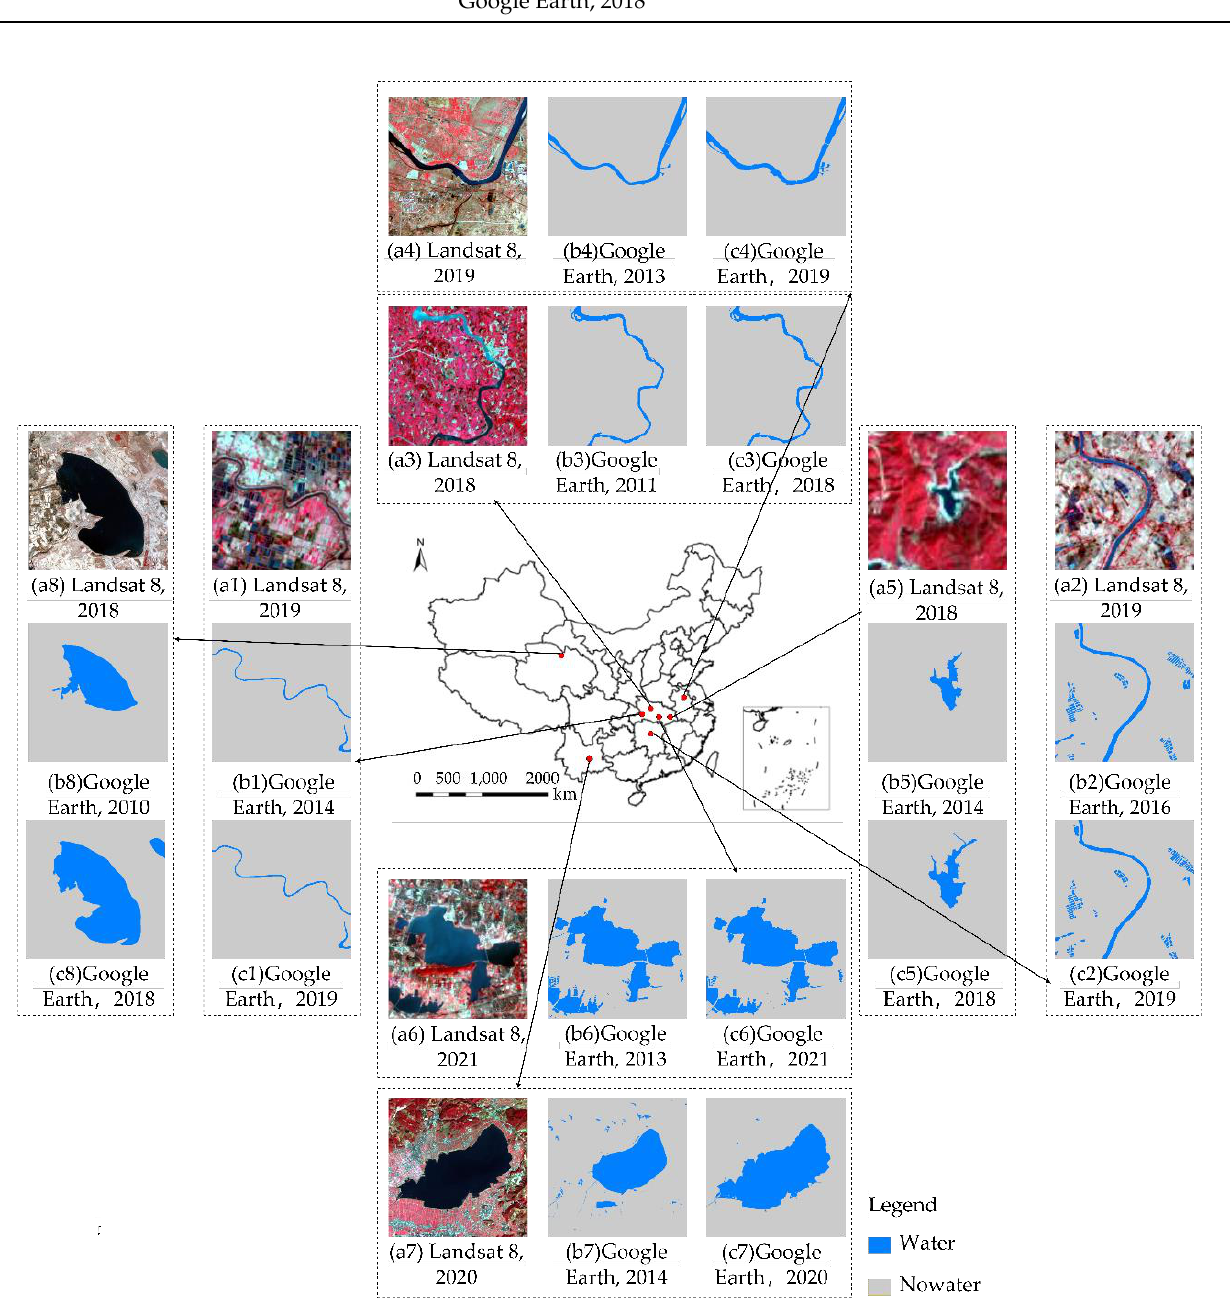
Figure 1. Data used in the experiments: (1) ( a1 – c1 ) are the data for the micro river; (2) ( a2 – c2 ) are the data for the small river; (3) ( a3 – c3 ) are the data for the medium river; (4) ( a4 – c4 ) are the data for the large river; (5) ( a5 – c5 ) are the data for the micro lake; (6) ( a6 – c6 ) are the data for the small lake; (7) ( a7 – c7 ) are the data for the medium lake; and (8) ( a8 – c8 ) are the data for the large lake.